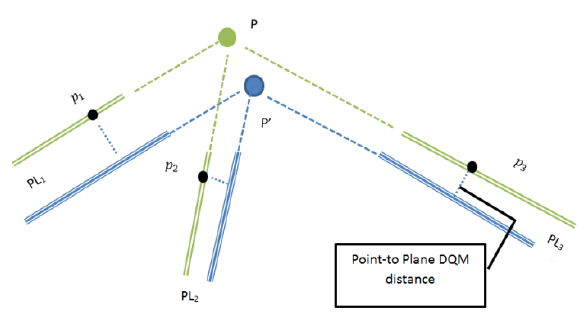
Figure 8 Three points the measured DQMs, the corresponding planar patches (PL1, PL2, PL3) in Swath #1(green) and Swath # 2 (blue) and their virtual point of intersection (P’ and P) are